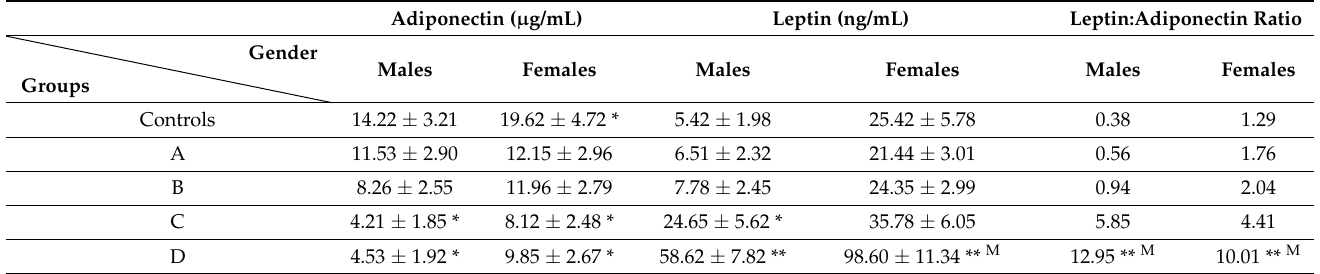
Table 3. Serum adiponectin and leptin concentration in T2DM patients and controls. Adiponectin ( µ g/mL) Leptin (ng/mL) Leptin:Adiponectin